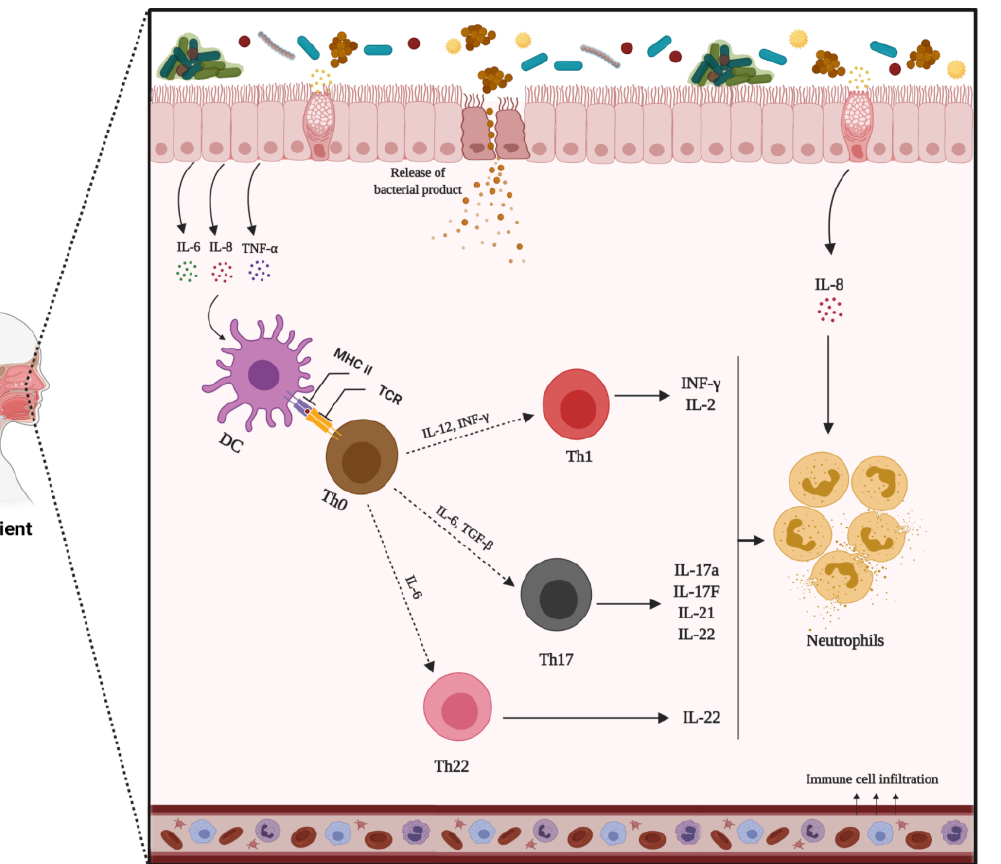
Figure 3. Mechanisms of non-type 2 inflammation in patients with chronic rhinosinusitis without nasal polyps (CRSsNP). In response to environmental stimuli, epithelial cells release inflammatory mediators that induce type 1 (Th1) or 17 (Th17) inflammatory pathways. Th1 and Th17 orchestrate in- flammation through the production of IFN- γ , IL-17a, and IL-22. In this pathway, B cell activation and differentiation into plasma cells can produce IgG antibodies that finally lead to neutrophil